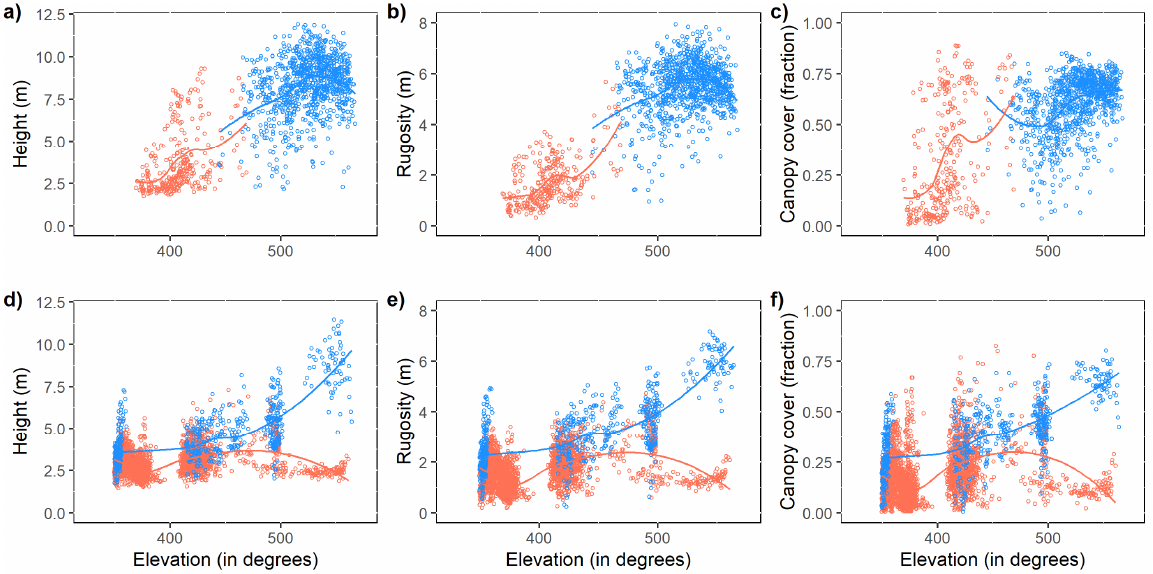
Figure 4. Relationships between different canopy metrics and elevation in deciduous and evergreen forests. Different colors indicate tree locations (blue in southern aspects and orange in northern aspects). The LOWESS smoothers indicated by blue and orange lines are for southern and northern aspects, respectively. Sub-plot ( a – c ) are for deciduous forests, while sub-plot ( d – f ) are for evergreen forests.